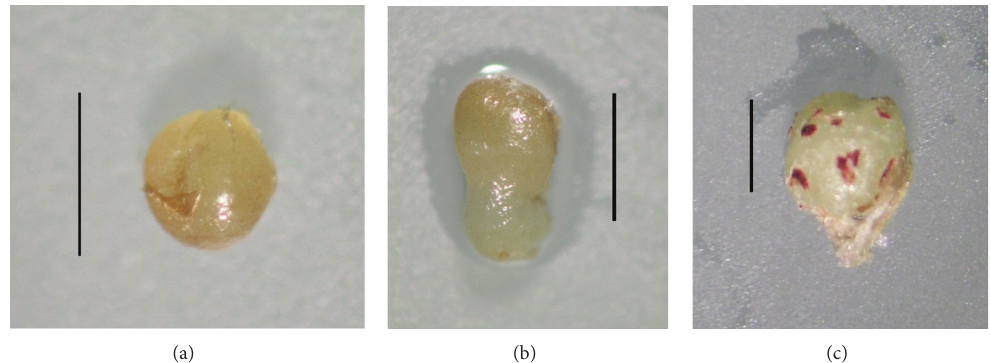
Figure 2: Developmental stages observed in somatic embryos obtained in direct somatic embryogenesis in the cactus C. tenuissima Ritt. forma mostruosa (bar = 1mm): (a) globular, (b) torpedo, and (c) shoot developed from somatic embryo.